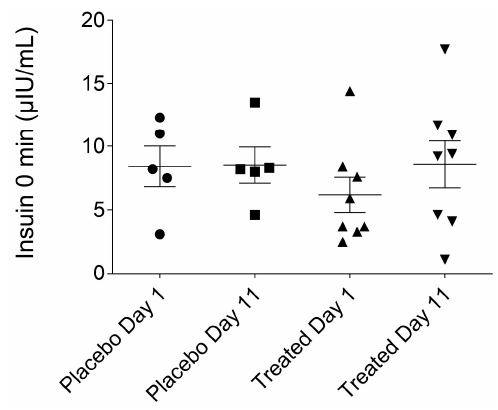
Figure 2. Fasting plasma insulin levels of the placebo- and fenugreek-treated subjects.